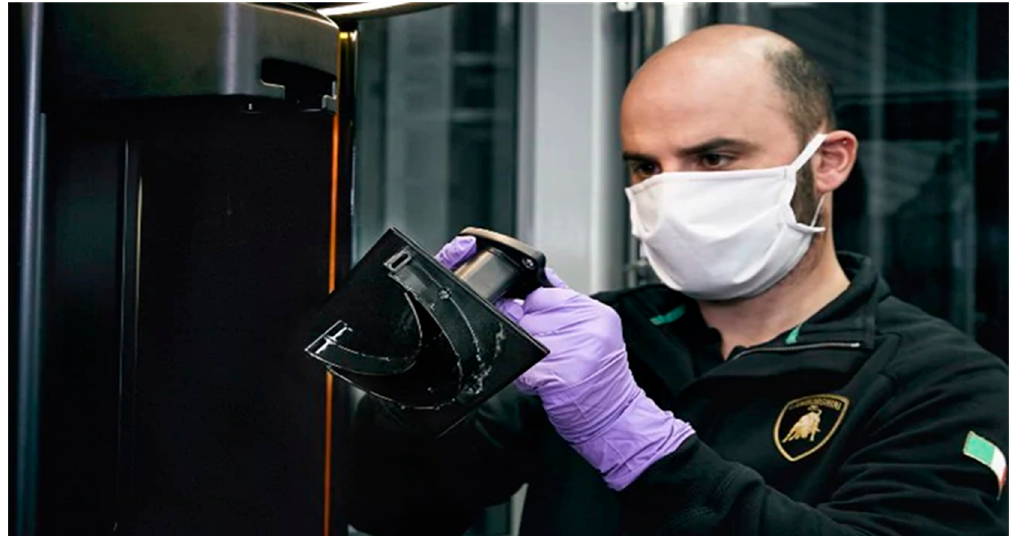
Figure 2. Personal Protection Equipment (PPE) used in the industrial scenario at one Lamborghini facility in Italy converted into PPE production after the COVID-19 outbreak. (Gentle permission of Automobili Lamborghini S.p.A.).